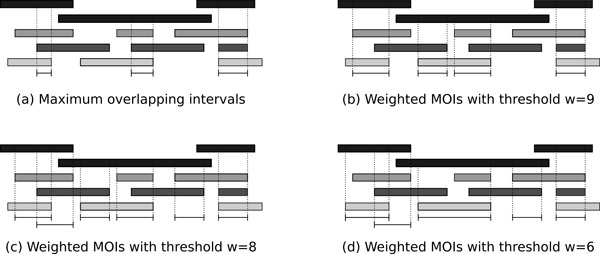
Example of weighted MOIs. Example for weighted MOIs in four collections (distinguished by different gray shadings). The weights of the collections are w(C1) = 2, w(C2) = 3, w(C3) = 3 and w(C4) = 4.